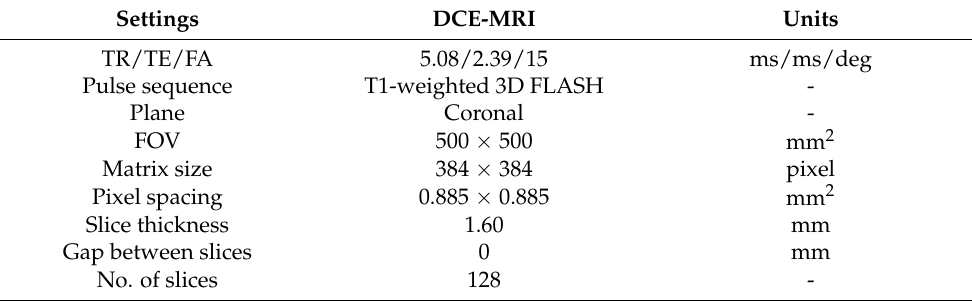
Table 1. Dynamic contrast-enhanced magnetic resonance imaging (DCE-MRI) scan settings.